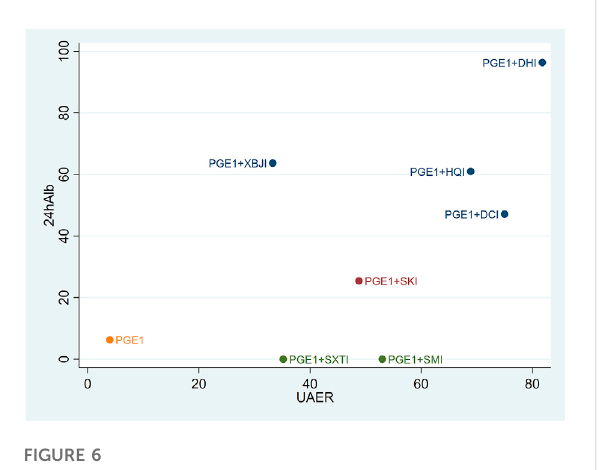
FIGURE 4 Cluster diagram of primary outcome indicators.